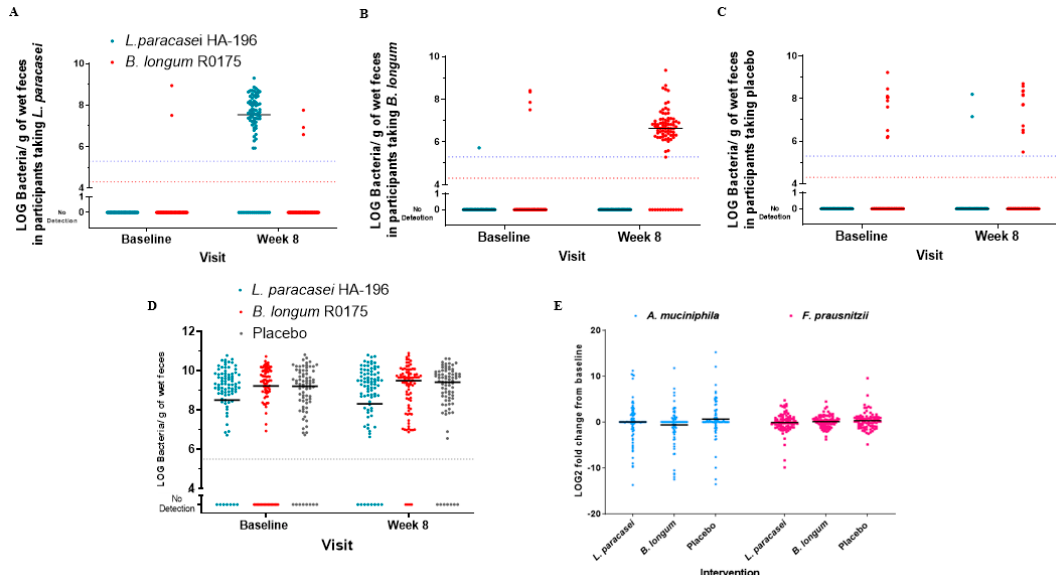
Figure 9. Effect of Lactobacillus paracasei HA-196 and Bifidobacterium longum R0175 on fecal microbial composition in participants with IBS. qPCR analysis of absolute quantification of B. longum (red dots) and L. paracasei (blue dots) in participants receiving ( A ) L. paracasei ( B ) B. longum, or ( C ) placebo; ( D ) Absolute quantification of Bifidobacterium species at baseline and 8 weeks with limit of quantification for each species represented by corresponding coloured dotted line; ( E ) relative quantification of Akkermansia muciniphila and Faecalibacterium prausnitzii in the three groups. A. muciniphila, Akkermansia